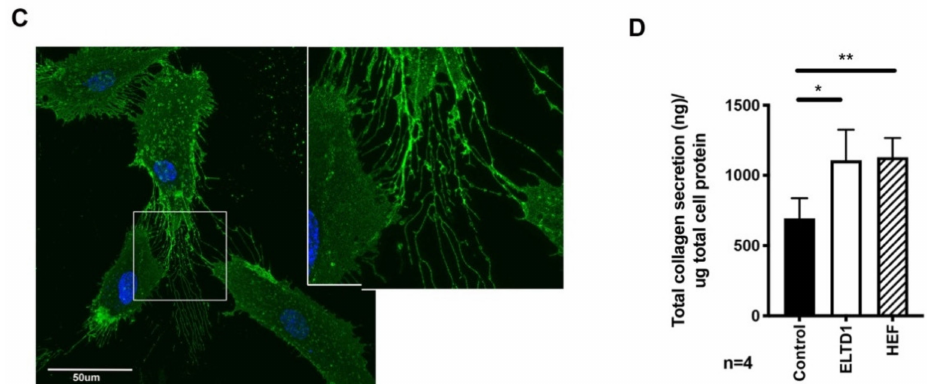
Figure 4. coELTD1 expression induces myofibroblast-like shape changes. ( A ) Fluorescent staining of actin (phalloidin) and paxillin in control and coELTD1 expressing HUVEC. Images were taken on a Zeiss LSM 880 Confocal Microscope (Zeiss) at 40 × magnification. ( B ) Still images taken from HA-tagged coELTD1 Video S3 at 10 min intervals. HUVEC cells were infected with HA-tagged coELTD1 and imaged 10 min after addition of HA-Alexa Fluor 488 using a Zeiss Observer spinning disc confocal microscope. ( C ) Membrane staining of non-permeabilized HUVEC cells expressing HA-tagged coELTD1 using anti-HA-Alexa Fluor 488 with zoomed inset of cell tracks. Images were taken on a Zeiss LSM 880 Confocal Microscope (Zeiss) at 63 × magnification. ( D ) Collagen assay performed on supernatant collected from HUVEC cells 120 h after infection with control or coELTD1 virus. * p <0.05; ** p